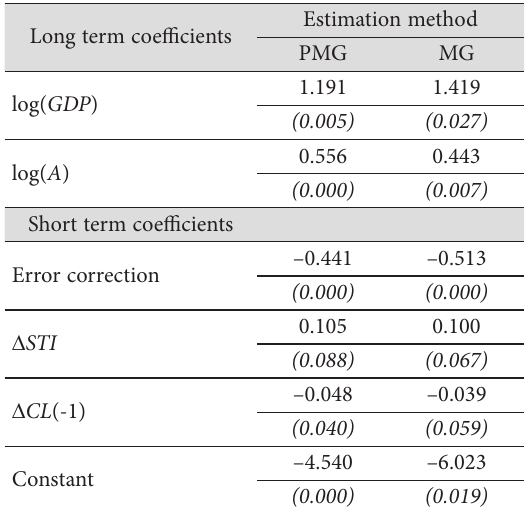
Table 2. Net interest income estimation